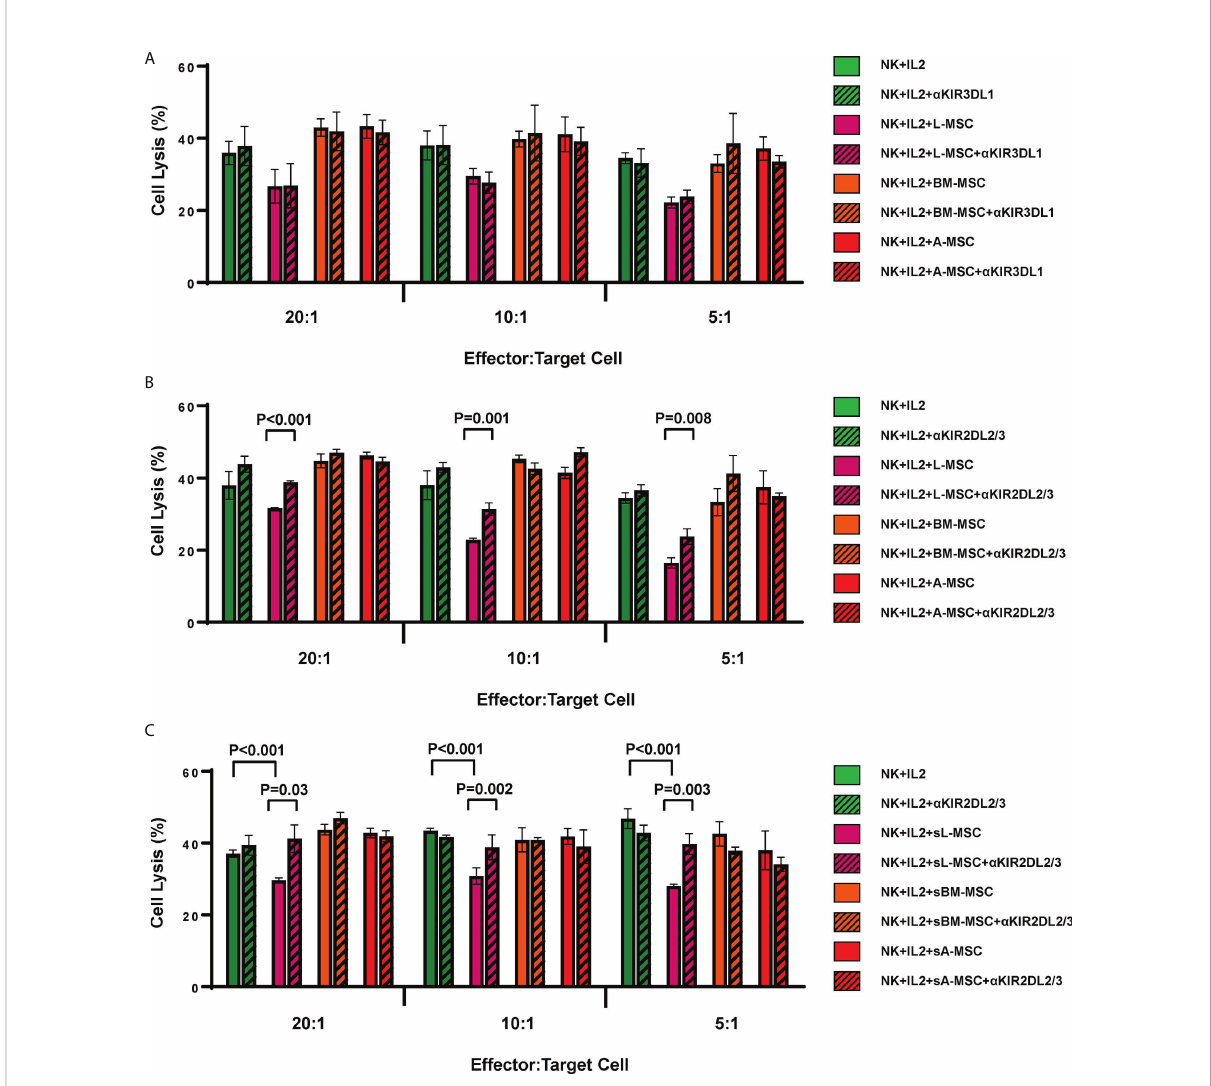
FIGURE 7 L-MSCs inhibit NK cell cytolytic function through secretion of soluble HLA-C. The two highly expressed NK cell inhibitors in the L-MSC secretome, soluble HLA-B-Bw4 and HLA-C1 were tested for their role in L-MSC-induced inhibition of NK cell cytolysis. The blockade of the KIR3DL1, receptor for HLA-B-Bw4 did not have an impact (A) , while blockade of KIR2DL2/3, receptor for HLA-C1 reversed the NK cell inhibition (B) . When NK cells were cultured for 3 days with supernatants of L-MSC cultures (sL-MSC), their cytolytic function was inhibited, whereas BM- MSC or A-MSC culture supernatants (sBM-MSC and sA-MSC, respectively) did not impair the NK cytolytic activity (C) . The results are representative of 3 independent experiments for panel A&B, and 2 independent experiments for panel (C) Each experiment was done in triplicates per groups. Paired Student ’ s t-test was used for the statistical analysis. L-MSC, liver mesenchymal stromal cell; BM-MSC, bone marrow mesenchymal stromal cell; A-MSC, adipose mesenchymal stromal cell; NK, natural